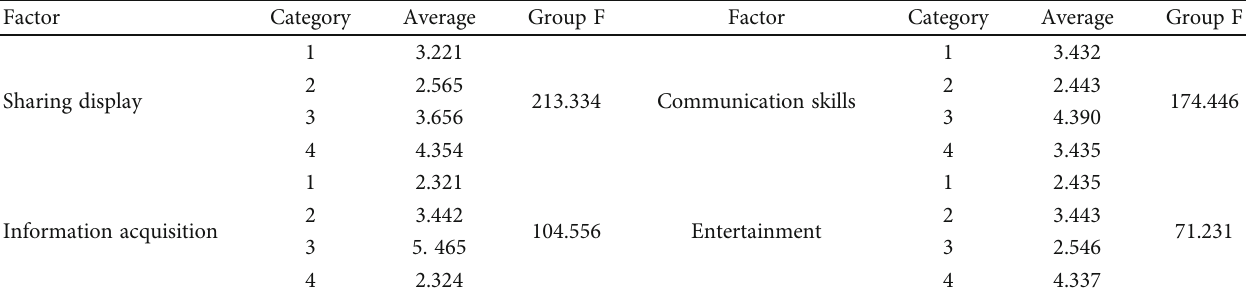
Table 2: Category and attribute factor